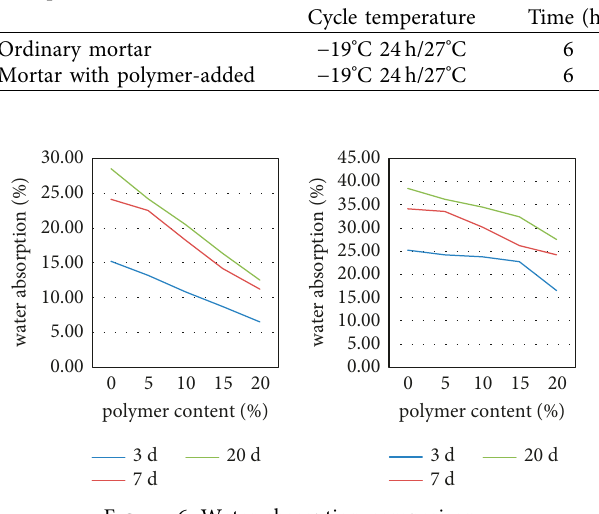
Figure 6: Water absorption comparison.